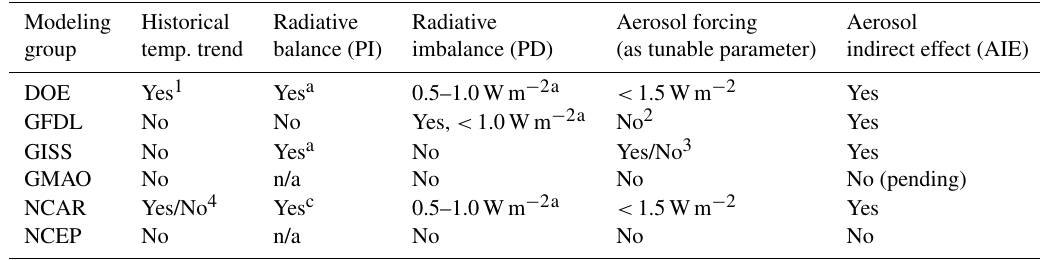
Table 2. Use of historical period trends and imbalances during the tuning process. Modeling Historical Radiative Radiative Aerosol forcing Aerosol group temp. trend balance (PI) (as tunable